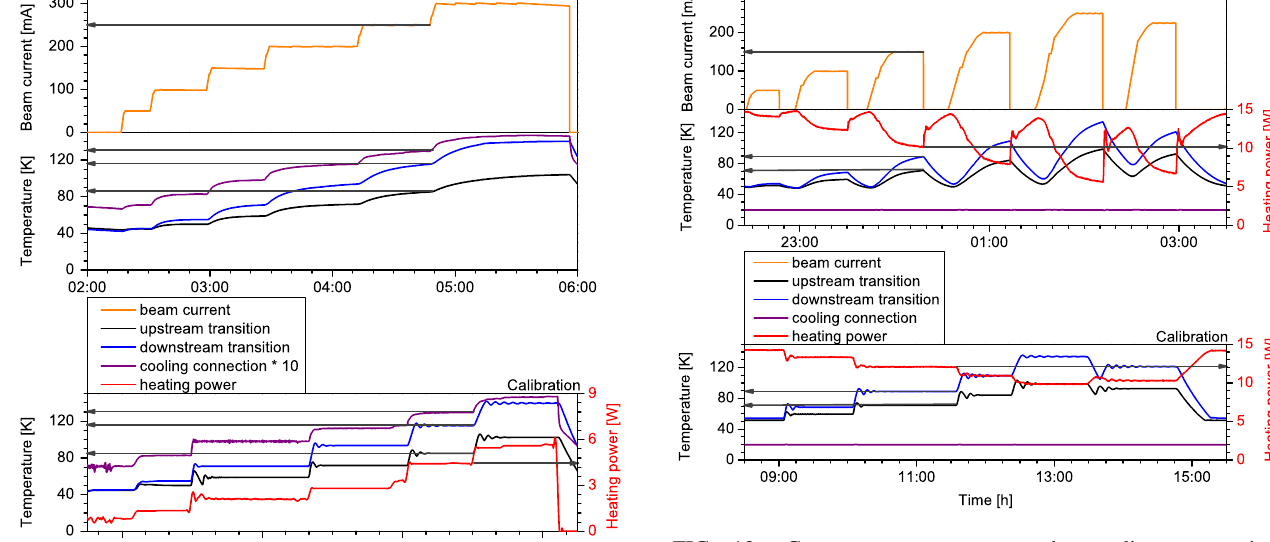
FIG. 12. Constant temperature at the cooling connection. Temperatures at cooling connection and transitions and heating power to the liner heaters during measurement (middle) and calibration (bottom) of a beam current ramp (top). The meas- urement is with 460